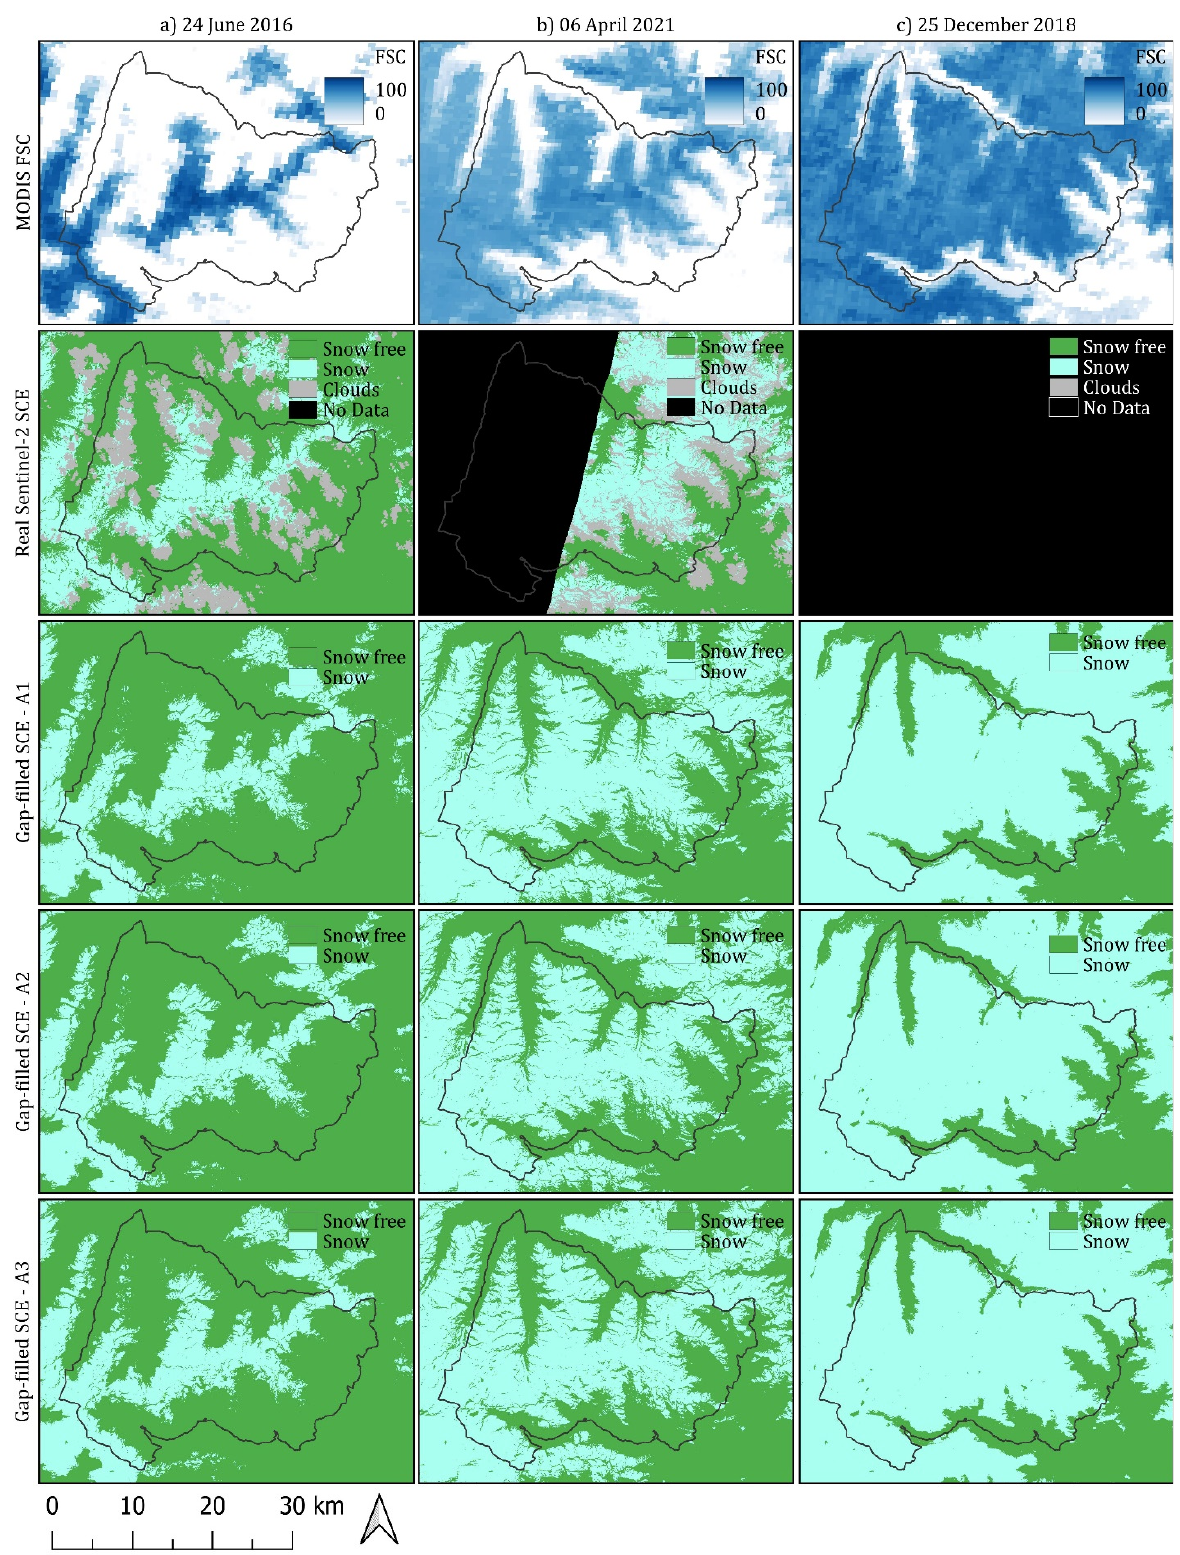
Figure 4 . Example of three scenes outputs. First row: MODIS Fractional Snow Cover (FSC) data; second row: real S2 Snow Cover Extent (SCE), with gaps due to clouds and cloud shadows and No Data; third to fifth rows: output SCE maps. In the days without S2 acquisition, as in ( c ), the entire scene is predicted.